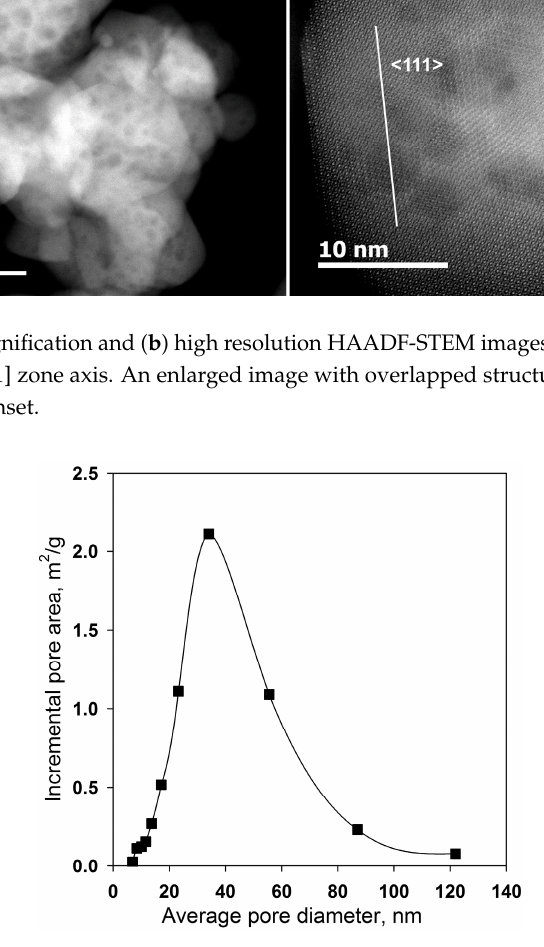
Figure 4. Pore size distribution calculated by BJH method.